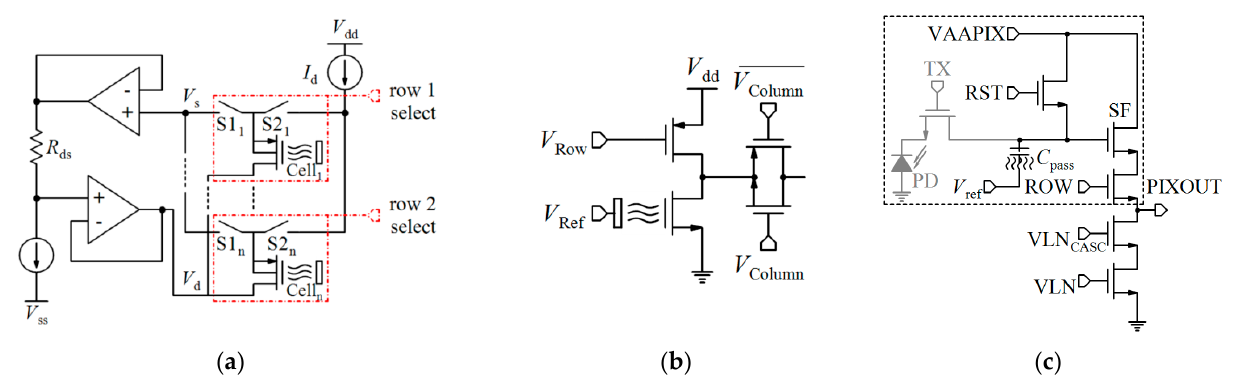
Figure 25. ( a ) Schematic of a column of 16 pixels in the n × n -array sensor chip; ( b ) a standard ISFET pixel readout; ( c ) a dual-pixel schematic including a CMOS image sensor and a source follower.